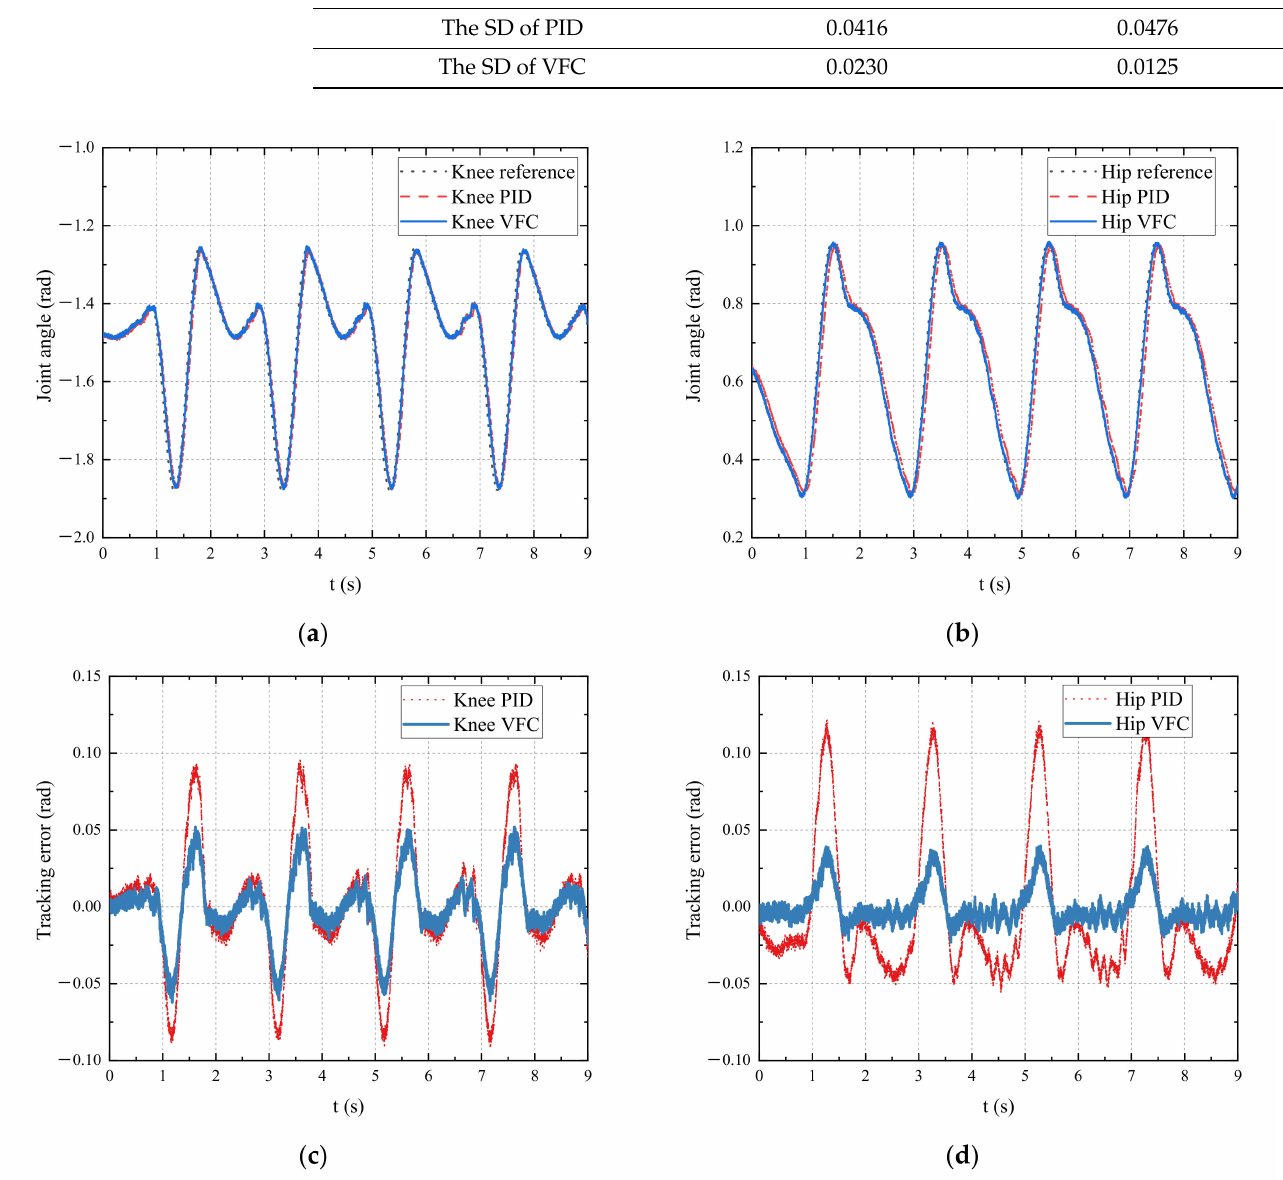
Figure 12. Comparison of two controllers in joint trajectory tracking and error: ( a ) knee trajectory; ( b ) hip trajectory; ( c ) knee tracking error; ( d ) hip tracking